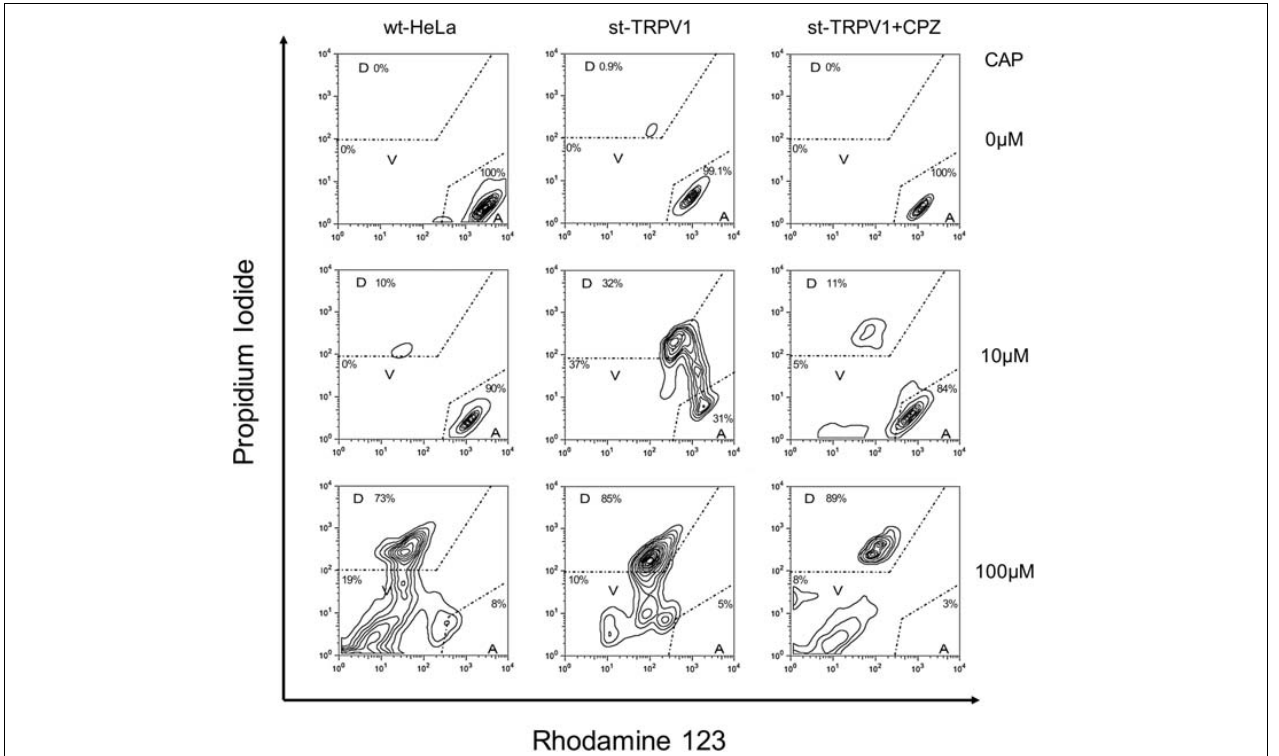
FIGURE 2 | TRPV1 expression increases CAP-induced cell death. Representative flow cytometry dot plot output and quantification depicting wt-HeLa cells and st-TRPV1 HeLa cells exposed to 0, 10, and 100 µ M CAP for 24 h in the presence or absence of 10 µ M CPZ. Cell death progression was evaluated using PI (to assess plasma membrane integrity) and Rho123 (to assess mitochondrial membrane potential). Cell state progression is symbolized as A (alive), V (vulnerable), and D (dead). Data are shown as mean ± SEM ( n = 6).